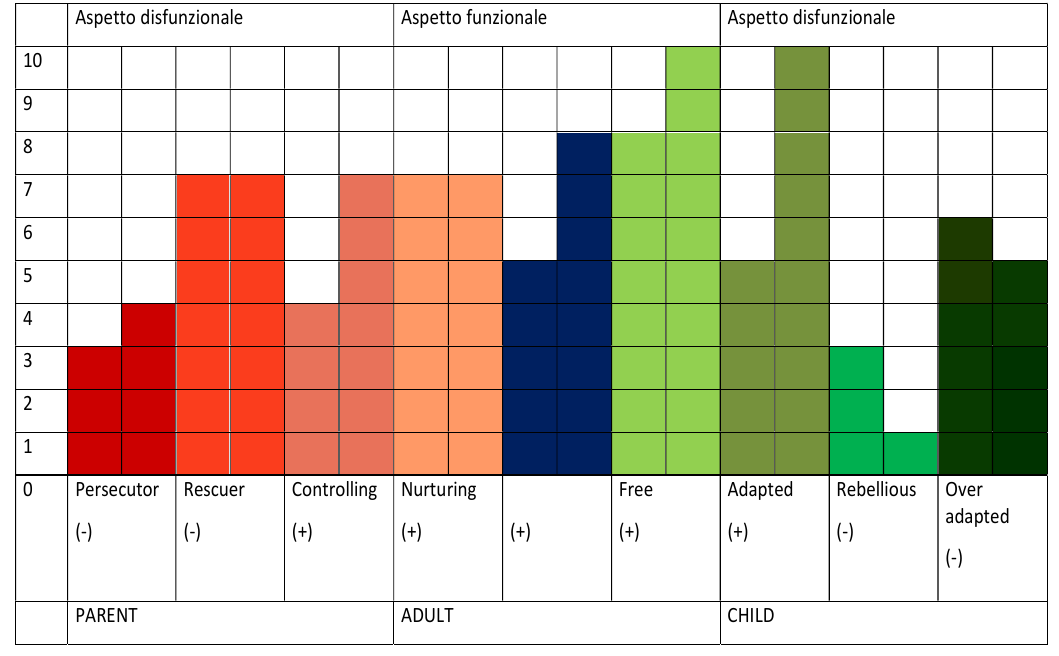
Chart 2: An example of an